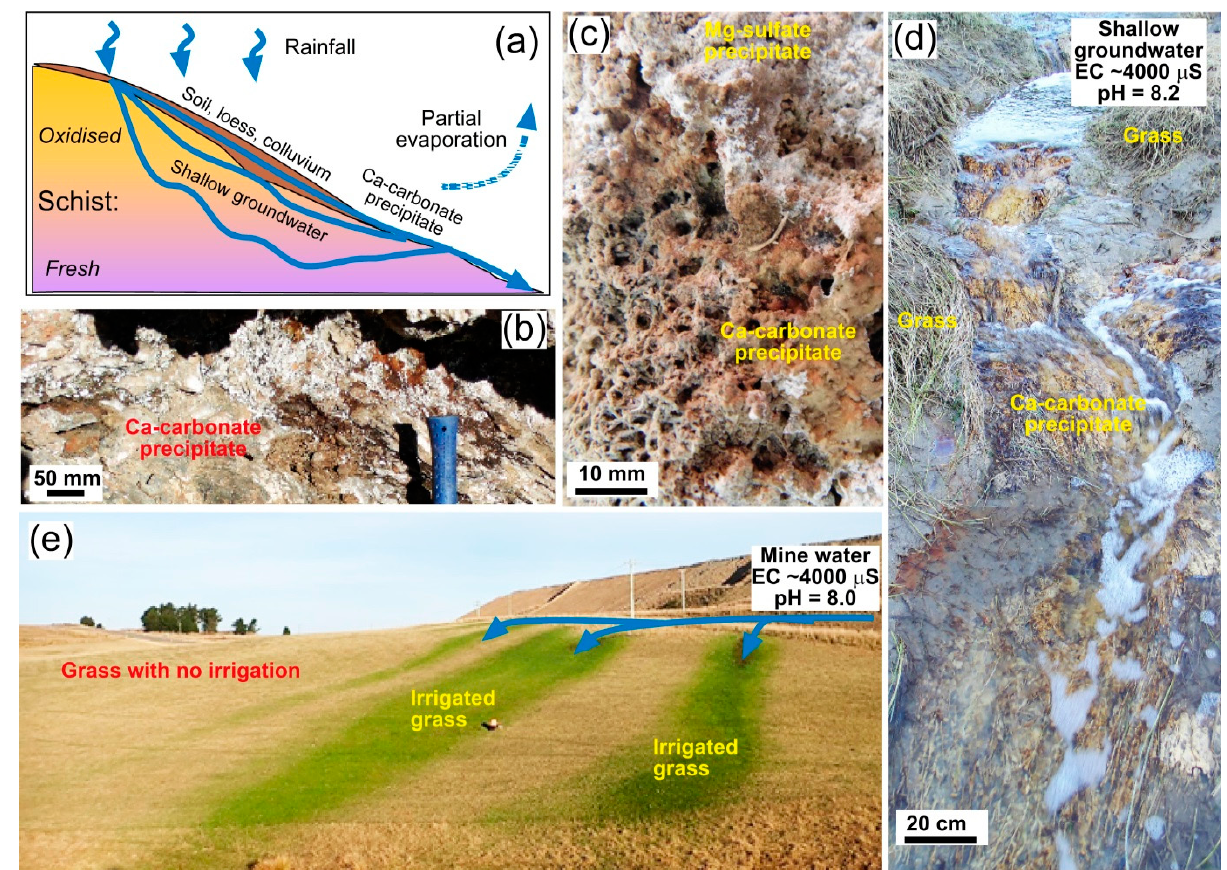
Figure 2. Outline of key features of typical water-rock interaction in Otago Schist rocks. ( a ) Cartoon cross section showing passage of shallow groundwater through schist, with partial evaporation of discharge springs and associated precipitates that are dominated by Ca-carbonate. ( b ) Outcrop view of Ca-carbonate precipitates from basement seeps. ( c ) Ca-carbonate precipitate from a spring emanating from a schist waste rock pile at Macraes mine (cf Figure 1a), with late-stage encrustations of epsomite. ( d ) Grassland stream of high-EC spring water from schist waste rock that deposited precipitates in ( c ), showing spontaneous Ca-carbonate precipitates on the stream bed. ( e ) Localised use of water similar to that in ( d ) for agricultural irrigation.